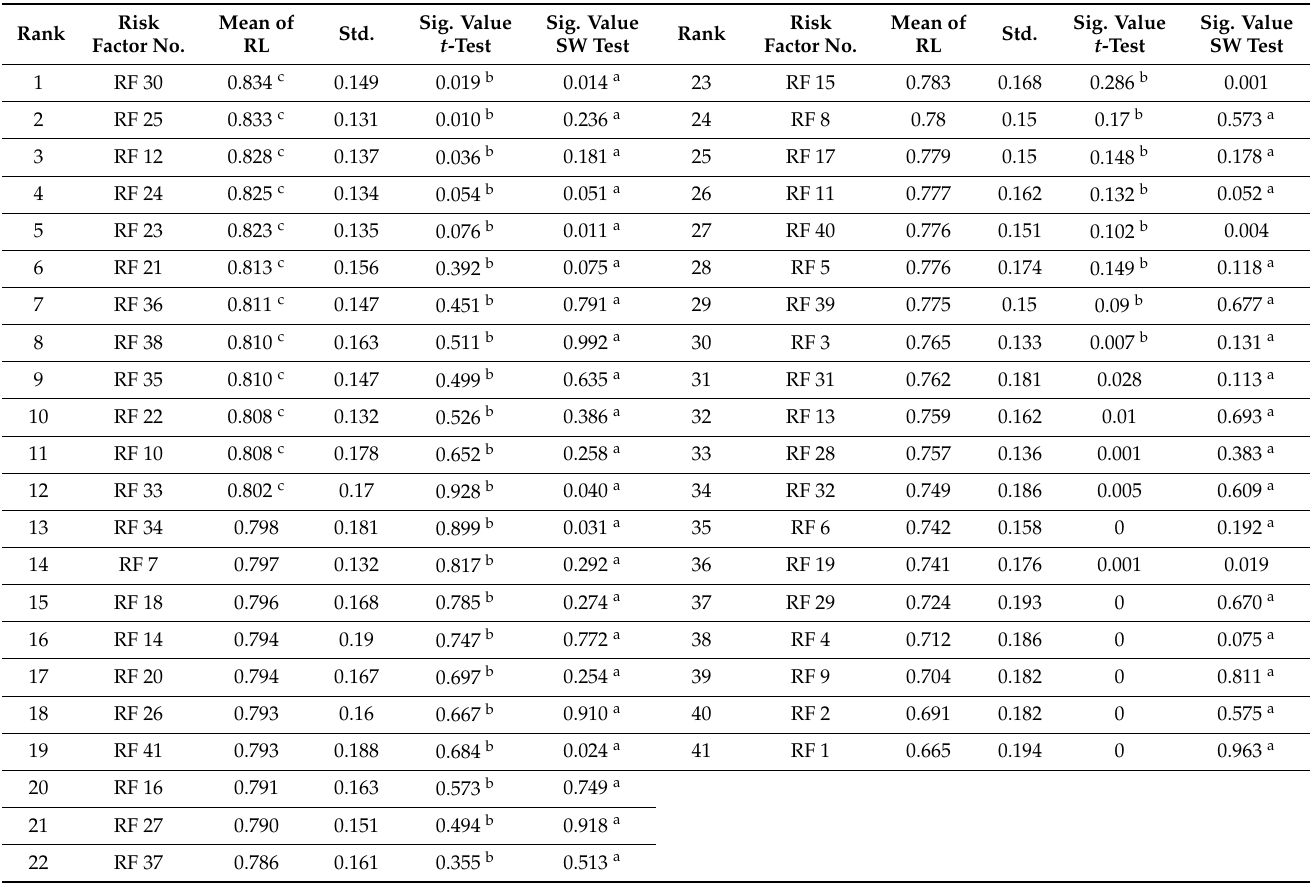
Table 3. The collected data analysis